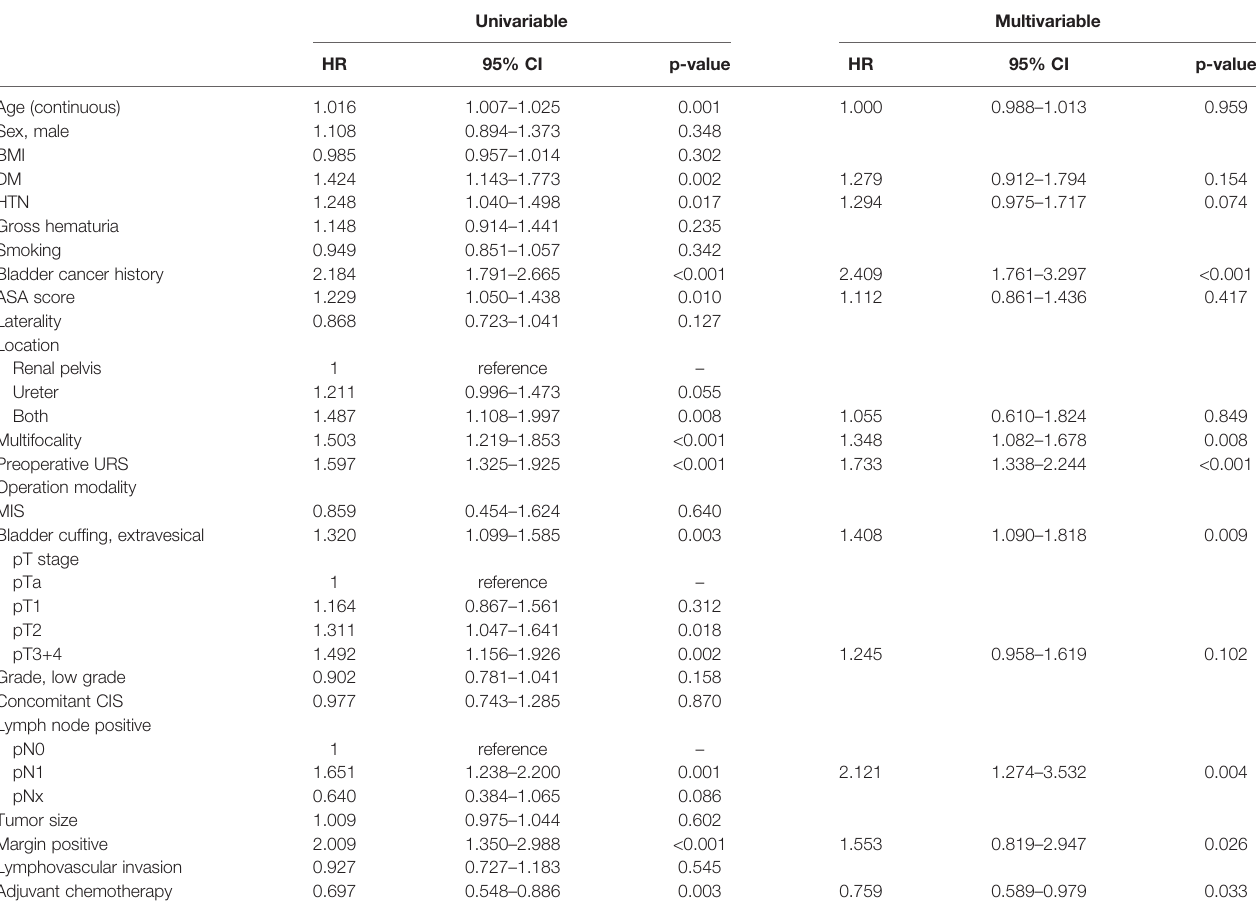
TABLE 2 | Results of the univariable and multivariable Cox regression